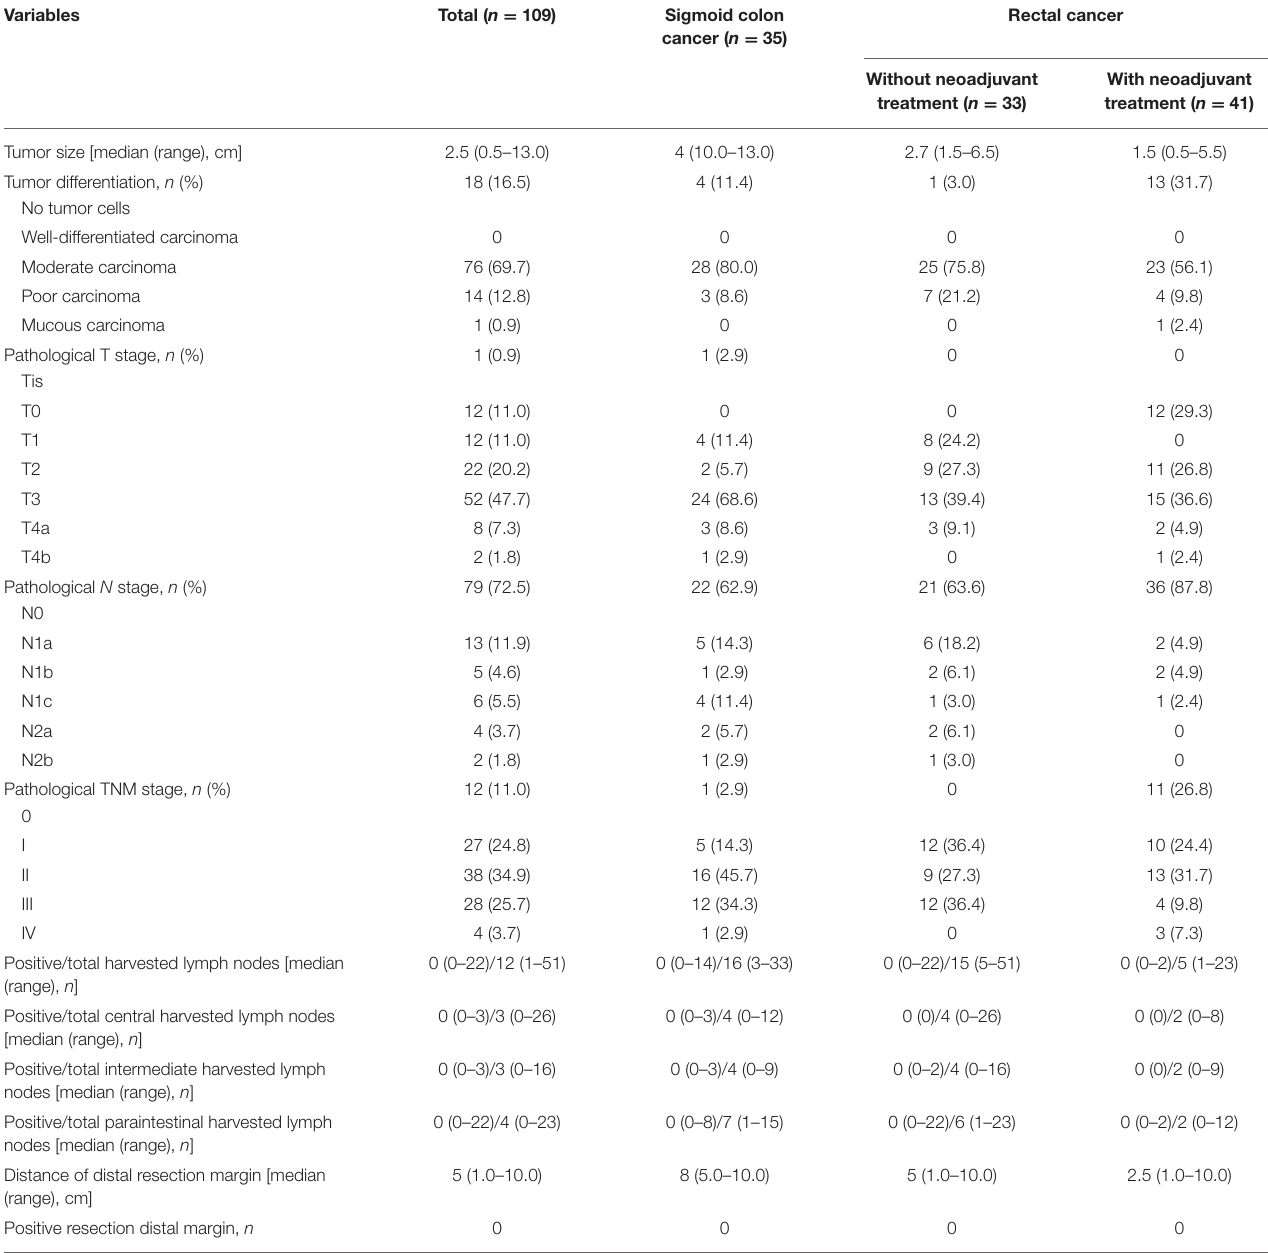
TABLE 3 | Pathologic outcomes.